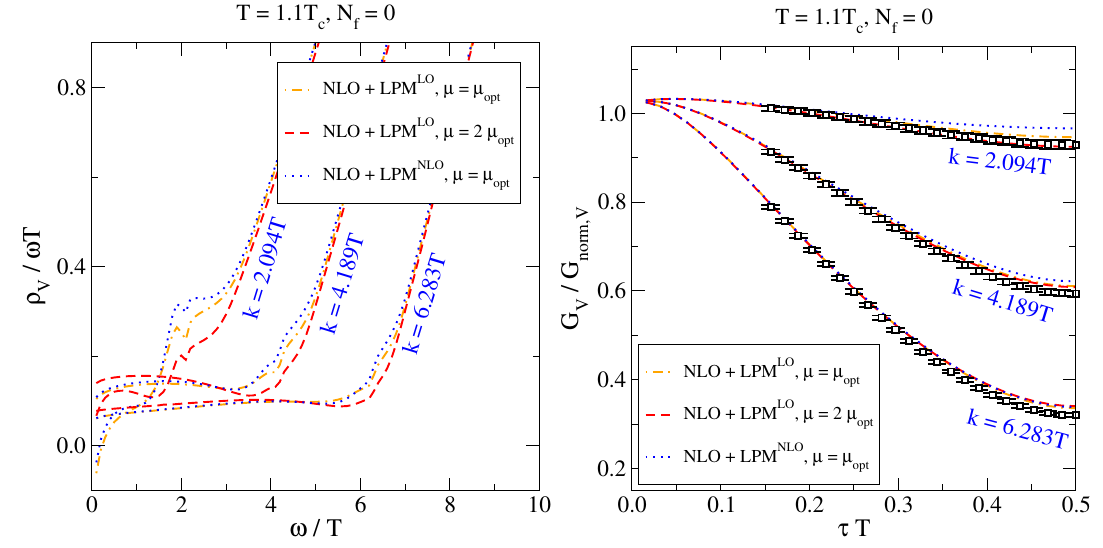
(left) and G (right) at T = 1 : 1 T V V